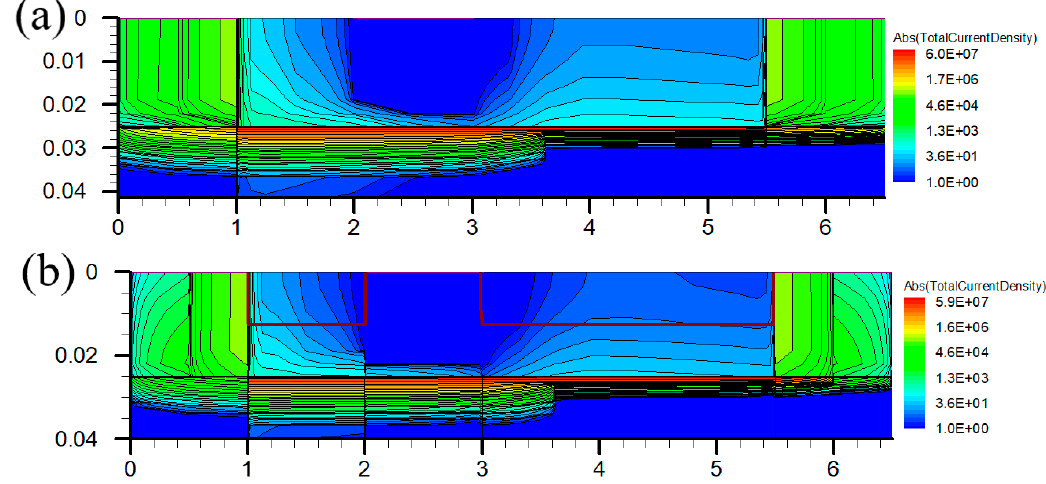
Figure 8. Distributions of the current density of ( a ) Con-HEMT and ( b ) PDBS-HEMT.